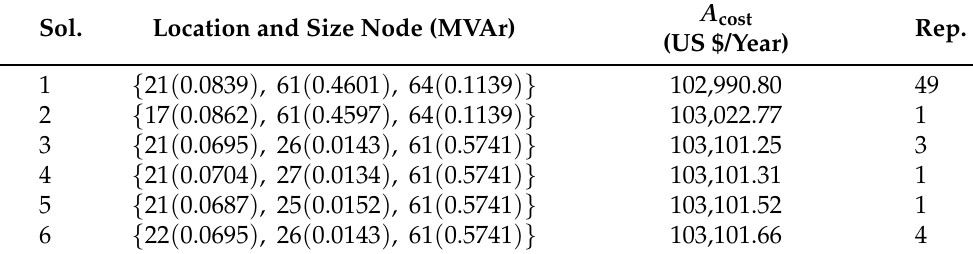
Table 9. Lists of solutions found by the proposed DCVSA in the IEEE 69-bus. Sol. Location and Size Node (MVAr)